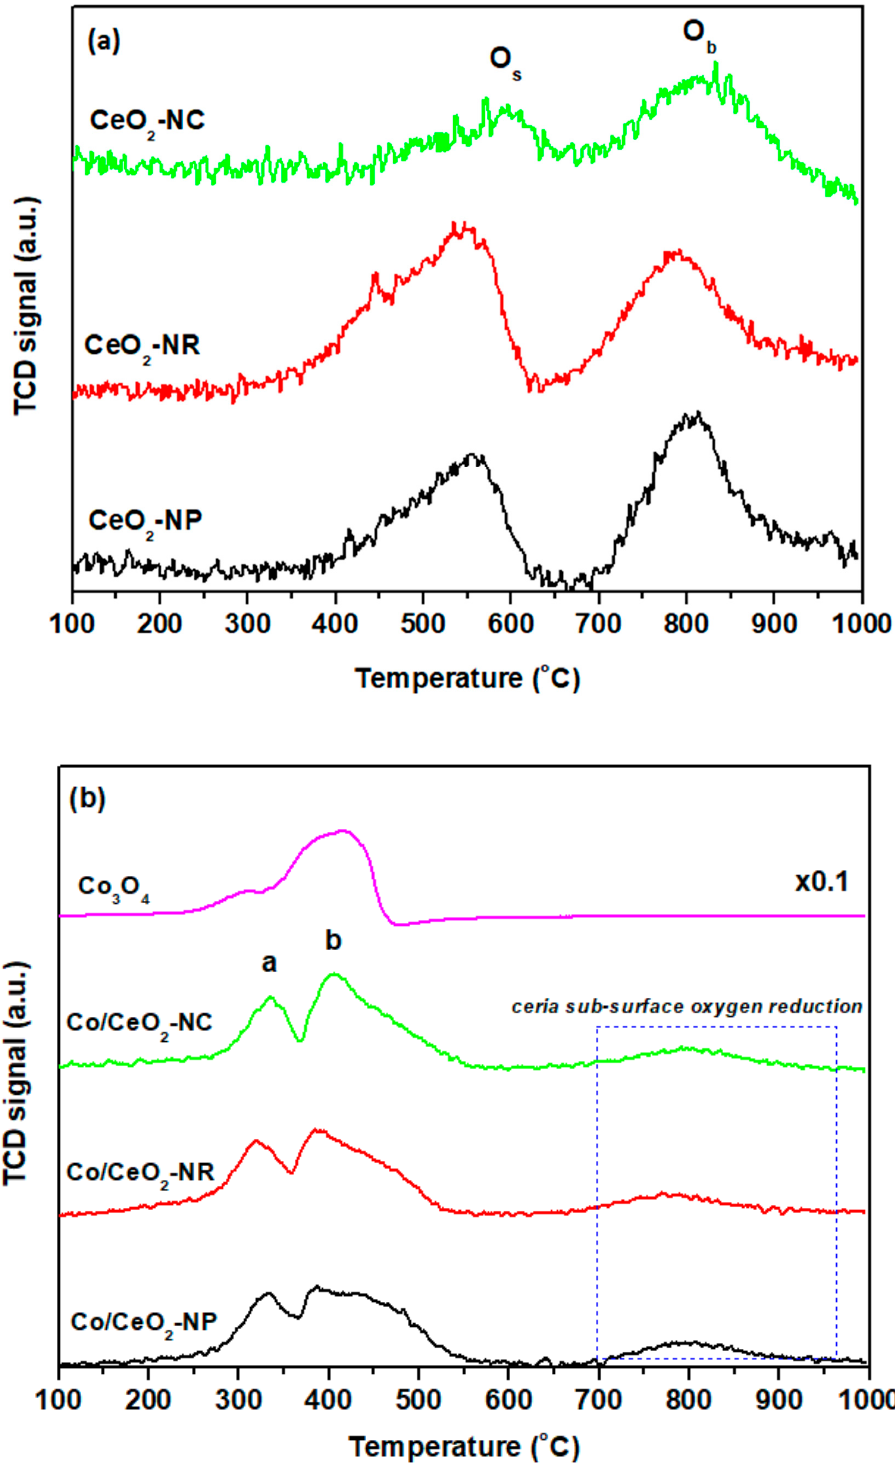
Figure 4. The H 2 -TPR profiles of ( a ) bare CeO 2 and ( b ) Co 3 O 4 , Co/CeO 2 samples.